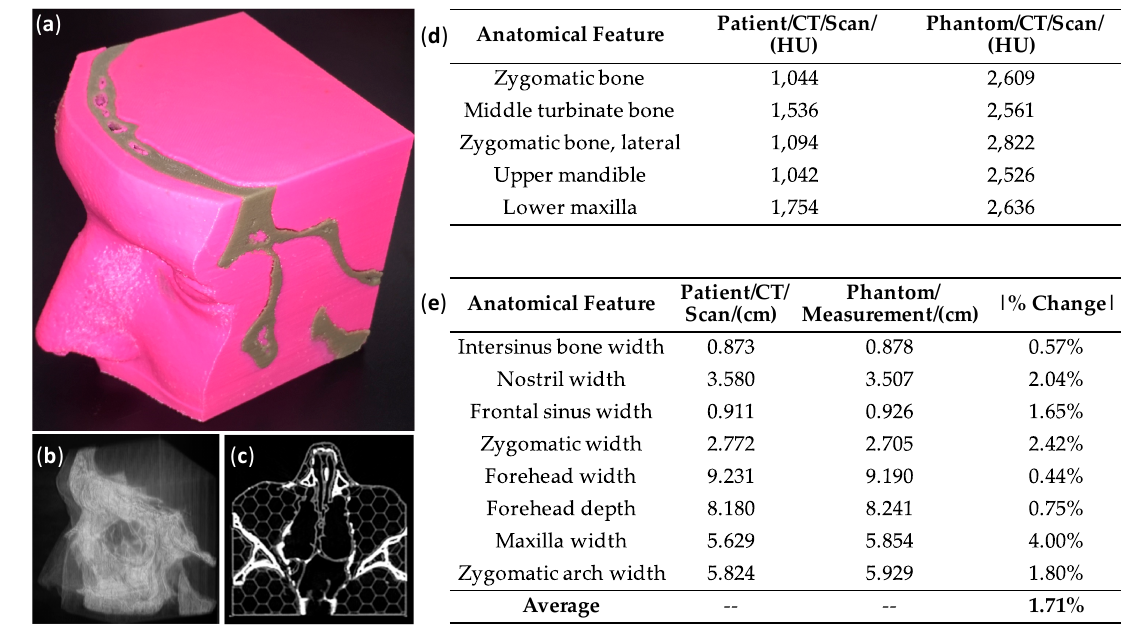
Figure 2. CT imaging and model accuracy of 3D-printed nasocranial phantom: ( a ) 3D-printed, multi-material nasocranial phantom with ABS soft tissue (pink) and ABS-bismuth 1 bone (gray); ( b ) coronal slice of clinical CT scan of nasocranial phantom, with bone regions appearing bright white due to high radiopacity; ( c ) 3D digital rendering of CT scan of phantom, showing high contrast of bone regions; ( d ) radiodensity data from original patient CT scan and from 3D-printed phantom CT scan at five coordinated bone locations; ( e ) distance measurements taken from the original patient CT scan data and from the physical 3D-printed phantom at eight coordinated locations, along with the absolute value of the percent change in distance between the two measures.